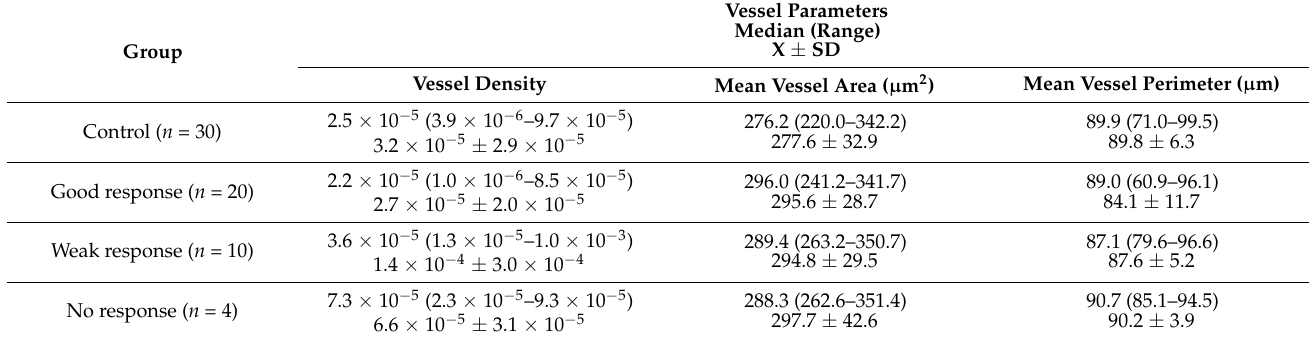
Table 3. Vessel parameters (based on CD31-positive endothelial cells) in fibroids in the control group and in the study groups after 3 months of treatment with ulipristal acetate (UPA): good, weak, and no response to treatment.